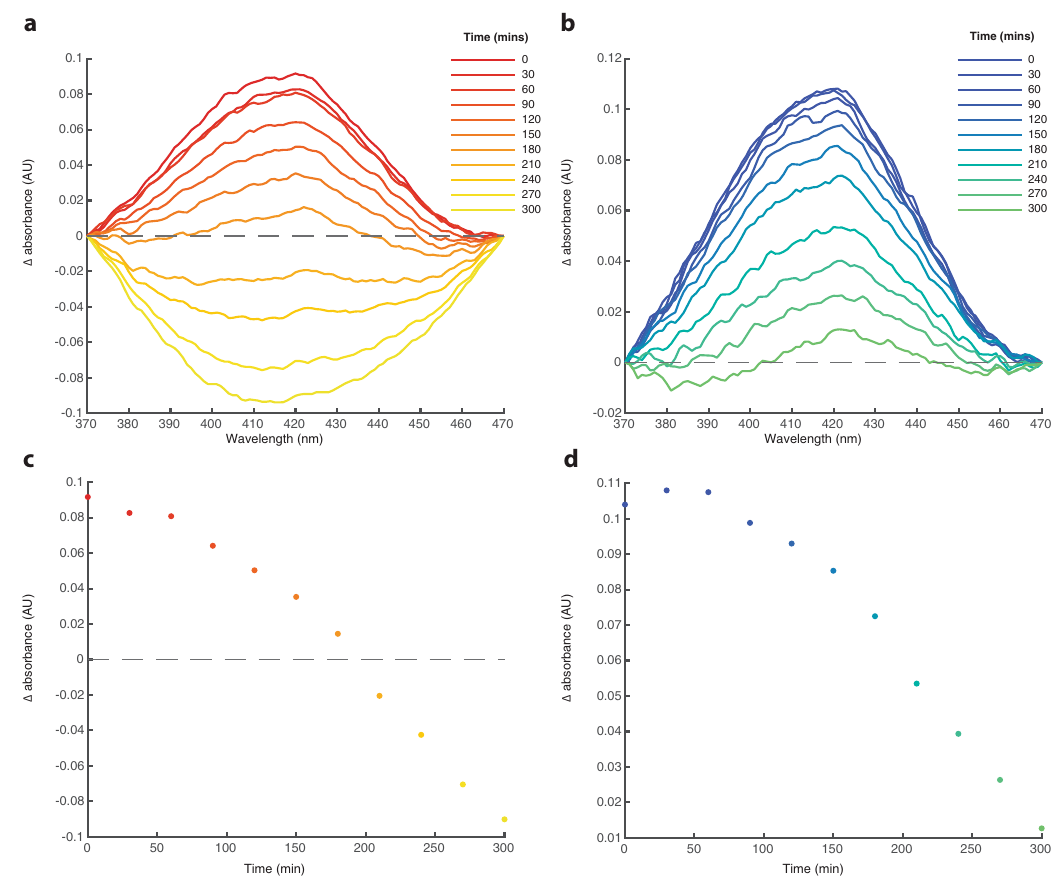
Fig. 6 Bicarbonate stabilises Cys-FeS clusters in the presence of O 2 . a Extracted UV-Vis 420 nm peaks for Cys-FeS cluster solutions prepared with 5 mM L-cysteine, 1 mM FeCl 3 and 1 mM Na 2 S analysed every 30 minutes for 5 h. b as in panel a with 10 mM NaHCO 3 included in solutions. c Plot of the extracted 420 nm peak heights as a function of time from data in panel ( a ). d Plot of the extracted 420 nm peak heights as a function of time from data in panel ( b ). Source data are provided as a Source data fi